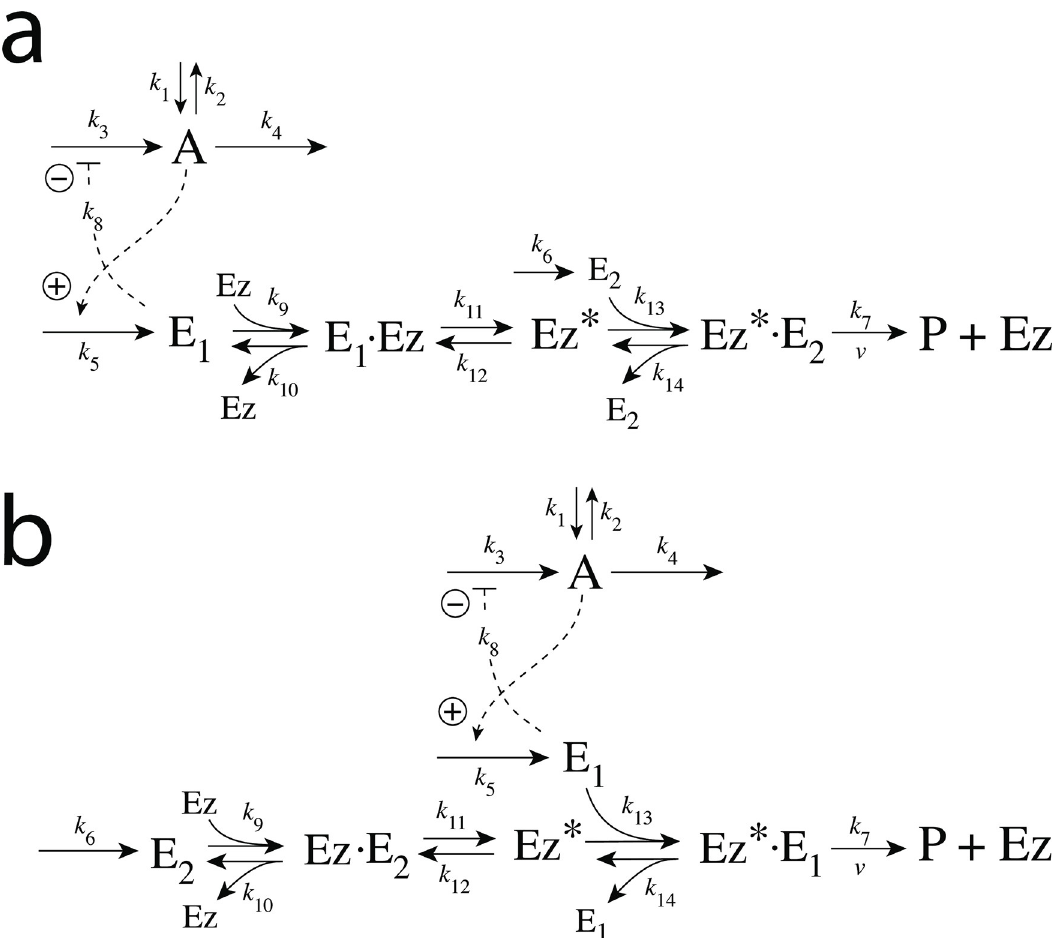
Fig 15. Enzymatic ping-pong mechanisms removing E 1 and E 2 in m2 dual-E controller. (a) E 1 binds first to Ez. (b) E 2 binds first to